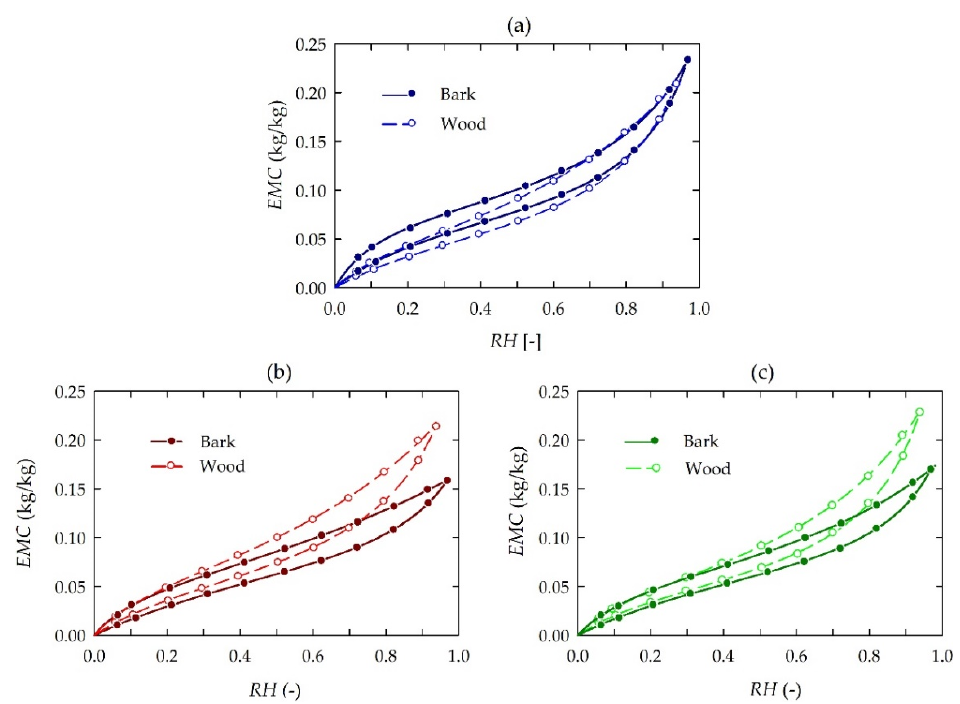
Figure 2. Experimental sorption data (dots) and results of fitting (lines) with the GDW model for Tilia cordata Mill. (bark and wood) at 20 °C depending on tree growth conditions: ( a ) low environmental stress, ( b ) medium environmental stress, ( c ) high environmental stress. Table 4. Coefficient coefficients of the sorption GDW model for lime ( Tilia cordata Mill.) bark and